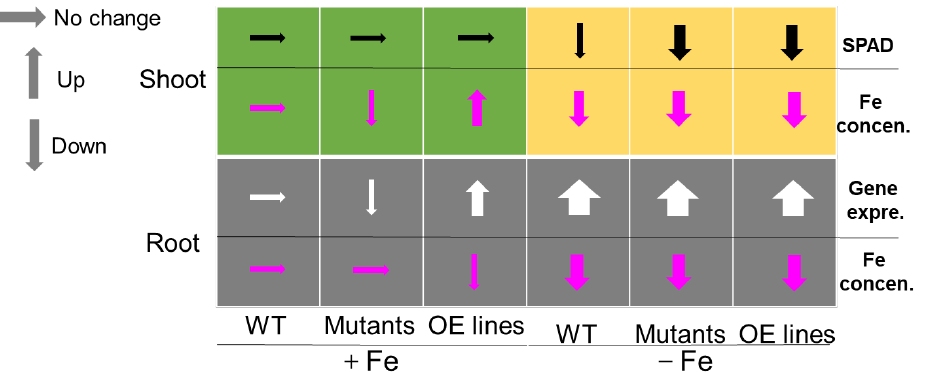
Figure 7. A schematic of OsbHLH057 in regulating Fe homeostasis. The effect of loss-of-function and overexpression of OsbHLH057 on increasing (up arrows) or decreasing (down arrows) physiological processes in the roots and shoots under Fe-sufficient (+Fe) and Fe-deficient ( − Fe) conditions. Black arrows, SPAD value; pink, Fe concentration; white, gene expression.